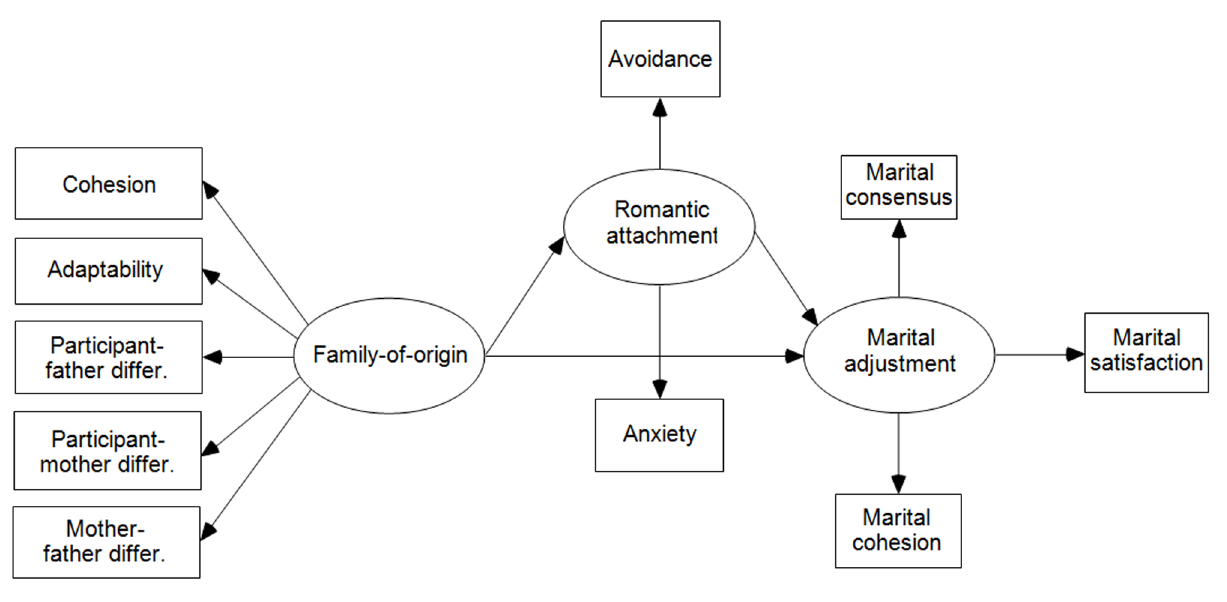
Figure 1. The hypothetical model of relationships among family-of-origin, romantic attachment, and marital